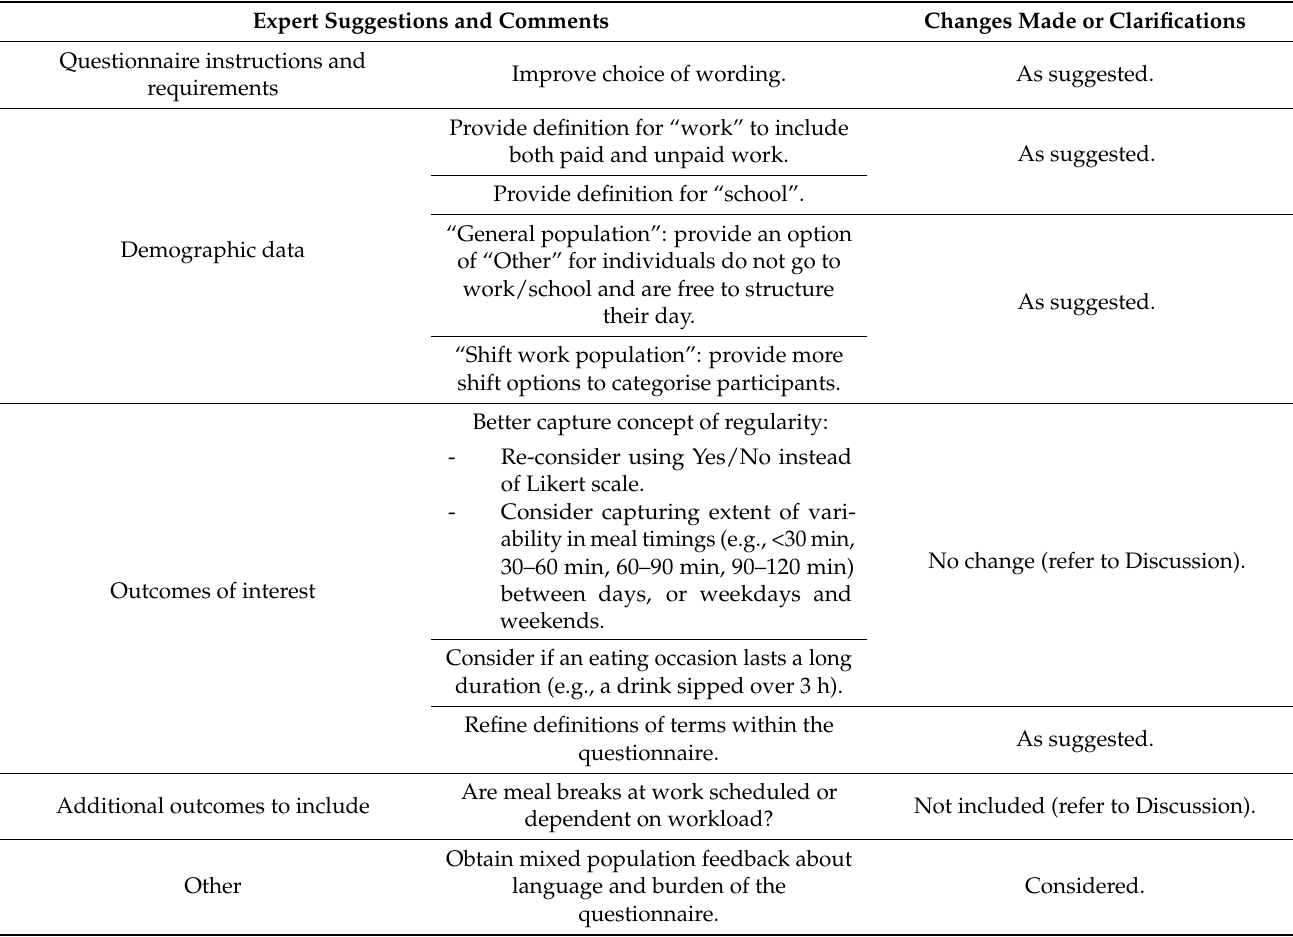
Table 5. Summary of comments provided by the expert panel and response by the research team in Round 3. Expert Suggestions and Comments Changes Made or Clarifications Questionnaire instructions and